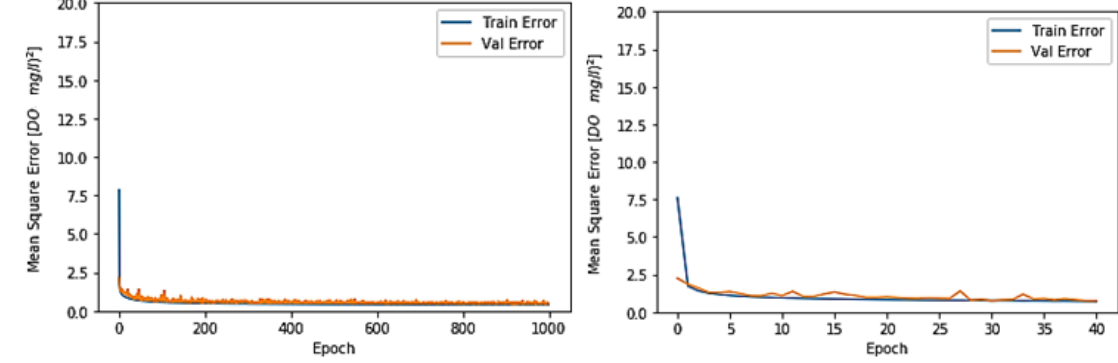
Figure 7. Mean square error (Toichio station, structure 4-64-64-1).